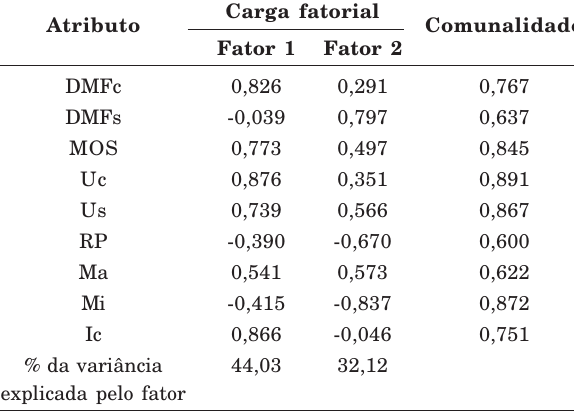
variância explicada na análise fatorial dos nove atributos analisados, após a rotação pelo método